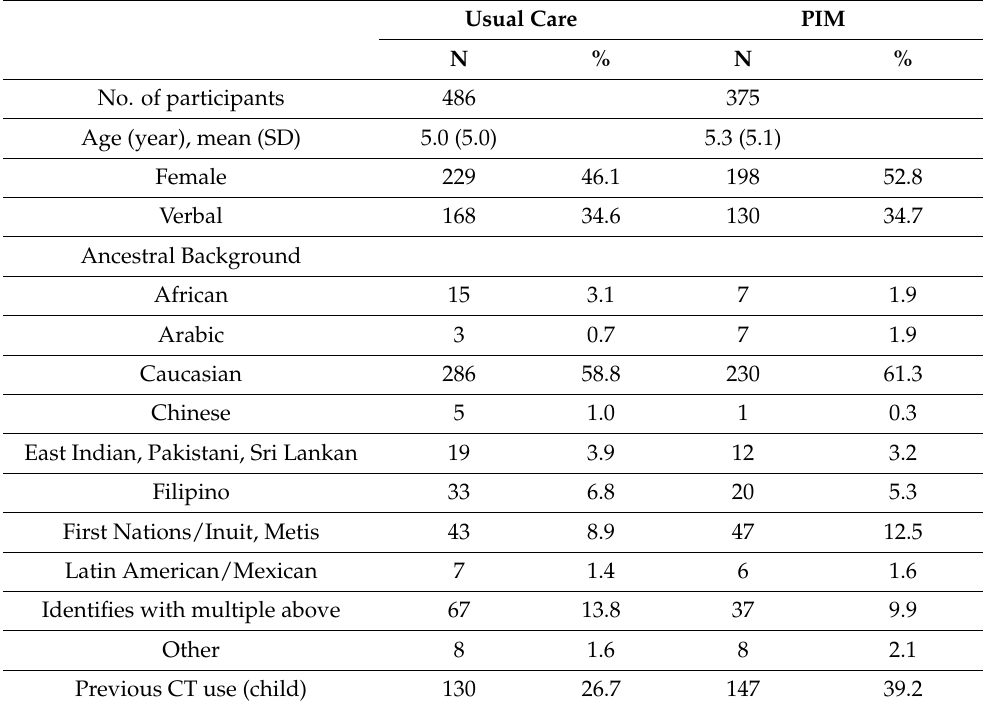
Table 1. Participant characteristics.